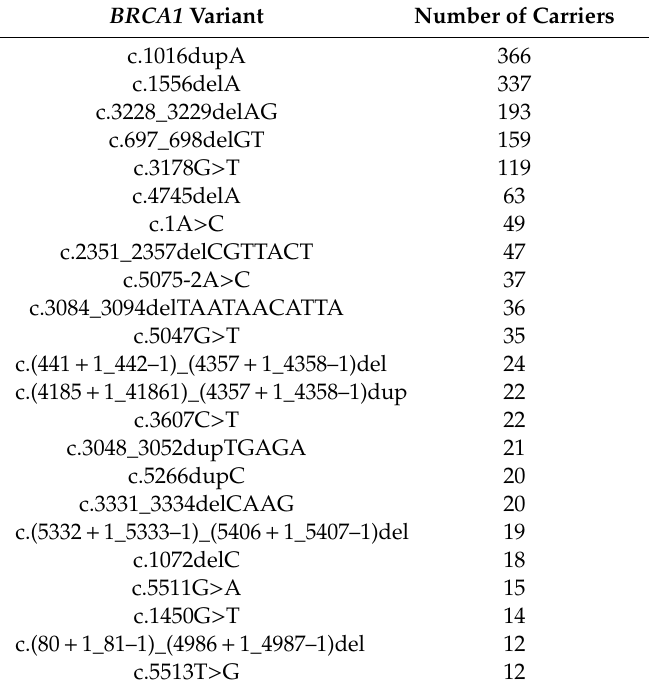
Table 3. Path_BRCA1 variants